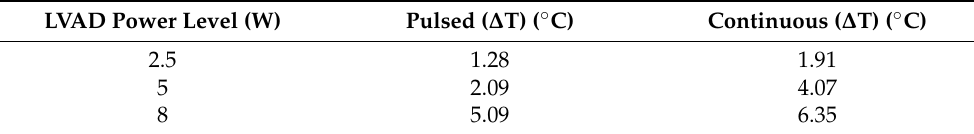
Table 6. Summary of the simulated temperatures ( ∆ T) inside the skin